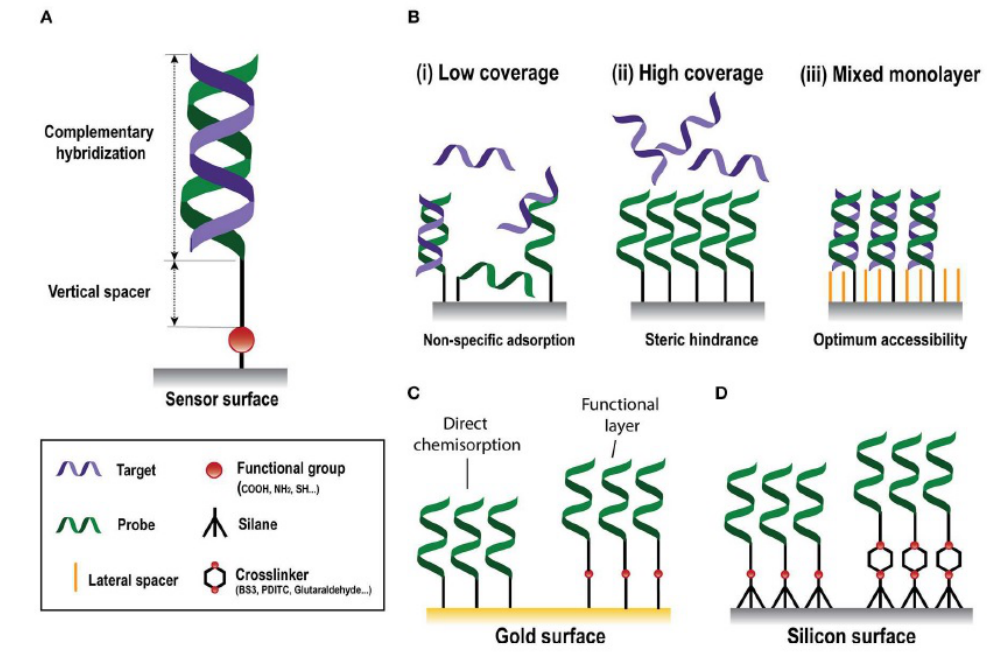
Figure 5. Surface functionalization with nucleic acids. ( A ) DNA probe hybridized with the complementary target. ( B ) Different surface coverages. ( C ) Gold surface with direct chemisorption ( left ) and covalent immobilization of the probe ( right ). ( D ) Silicon-functionalized surface with ( right ) or without ( left ) cross-linkers. (Reproduced from reference